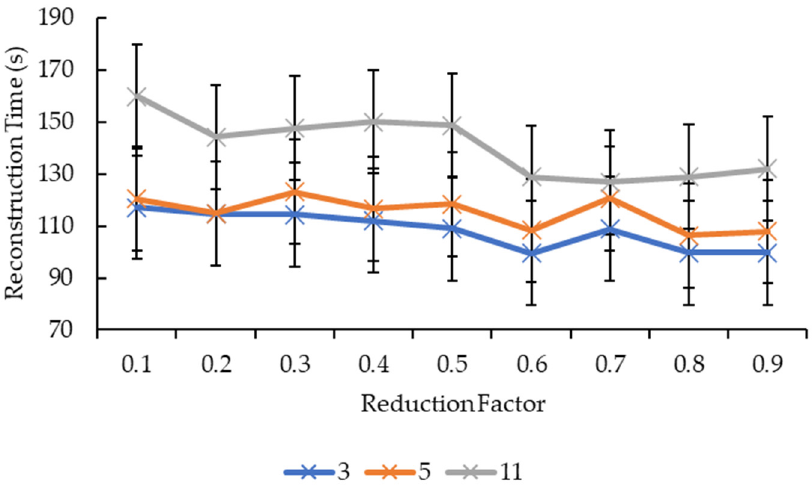
Figure 7. Graph of reconstruction time against convolution kernel size for convolution kernel box.